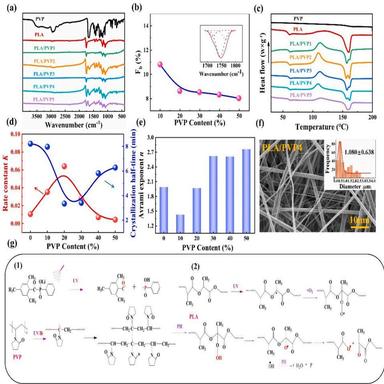
Structural properties of PLA/PVP crosslinked nanofibers membranes: (a) FTIR and (b) Fb of PLA/PVP nanofiber membranes. (c) DSC curve of PLA/PVP crosslinked nanofiber membranes (d) Rate constant K and crystallization half-time, and (e) Avrami exponent n of PLA/PVP crosslinked nanofiber membranes. (f) SEM images of the PLA/PVP4 nanofiber membranes. (g) UV cross-linking mechanism diagram.